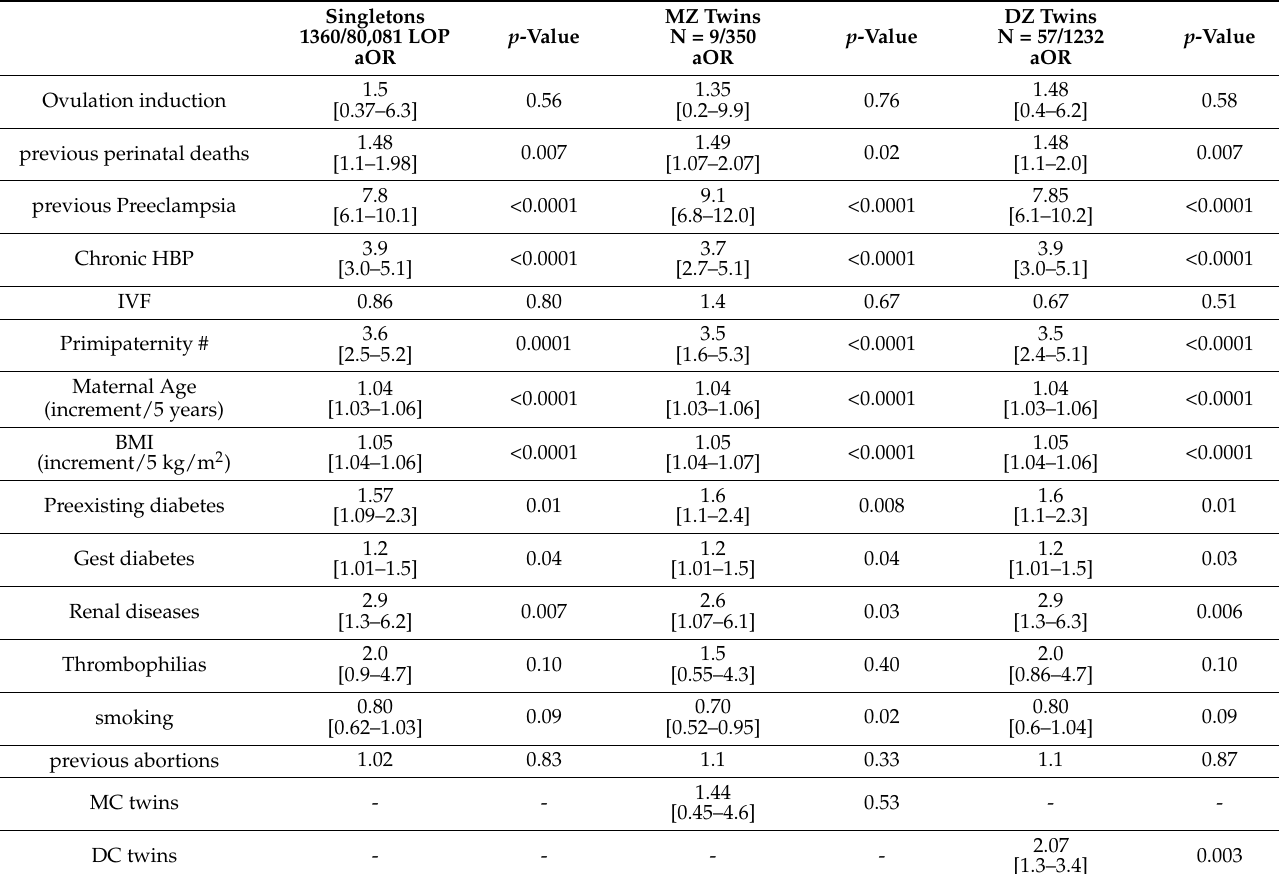
Table 4. Adjusted Odds ratios. Outcome: LATE ONSET preeclampsia LOP. Three logistic models including (1) singletons (2) monochorionic (3) dichorionic twins. Preeclamptic women PE (N = 2001), EOP (N = 641), LOP (N = 1360) versus controls, normotensive women (N = 78,085).